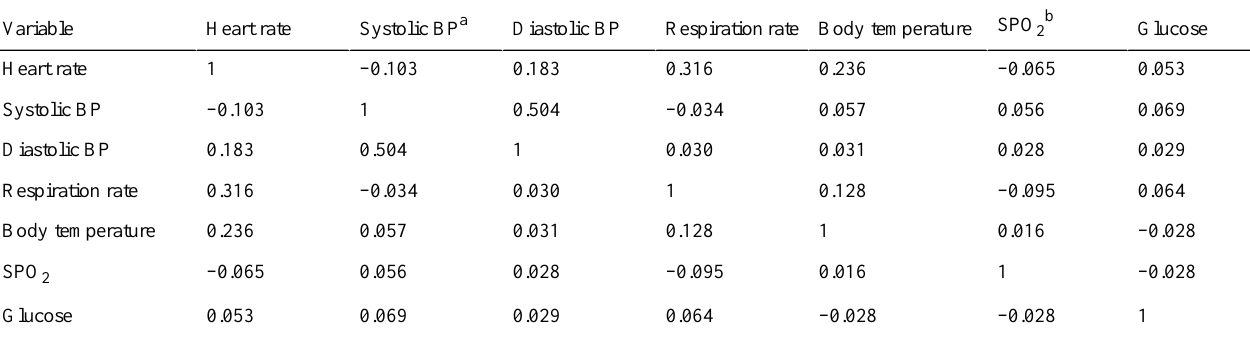
Table 7. Pearson correlation coefficients among the mean vital signs for a sample patient using the statistical